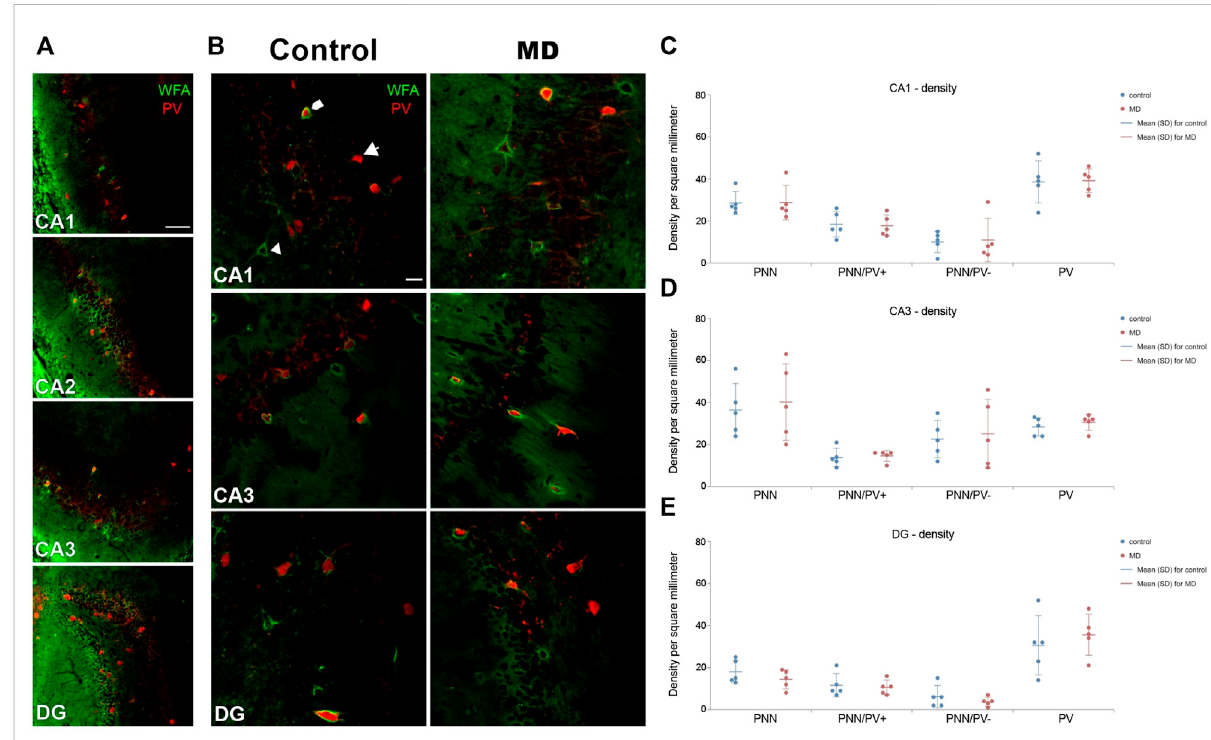
FIGURE 3 Effects of MD on WFA + perineuronal nets and PV + cell density in the hippocampus on PND60. (A) Low magni fi cation photomicrographs of double WFA/PV + immuno fl uorescence showing CA1, CA2, CA3, and DG. Note the characteristic “ mesh-like ” appearance of PNNs in CA2. (B) High magni fi cation photomicrographs of double WFA/PV + immuno fl uorescence showing PNNs surrounding PV + cells (pentagonal arrow), PNNs surroundingPV-cells(arrowhead)andPV+cellslackingPNNs(arrow)inCA1,CA3,andDG. Dotplotgraphs in (C – E) representingquanti fi cation ofresultsas means±SD(horizontalbars)and observedvalues(dots) intheCA1,CA3andDG,respectively. MDdidnotalterdensity ofPNNsnorPV + cells in any of the examined areas. Average number of evaluated PNNs per animal: CA1 = 36, CA3 = 42, DG = 21. Hippocampal sub fi elds CA1 (CA1), CA2 (CA2), and CA3 (CA3), dentate gyrus (DG), maternally deprived rats (MD). Scale bars in A and B = 100 and 25 μ m,